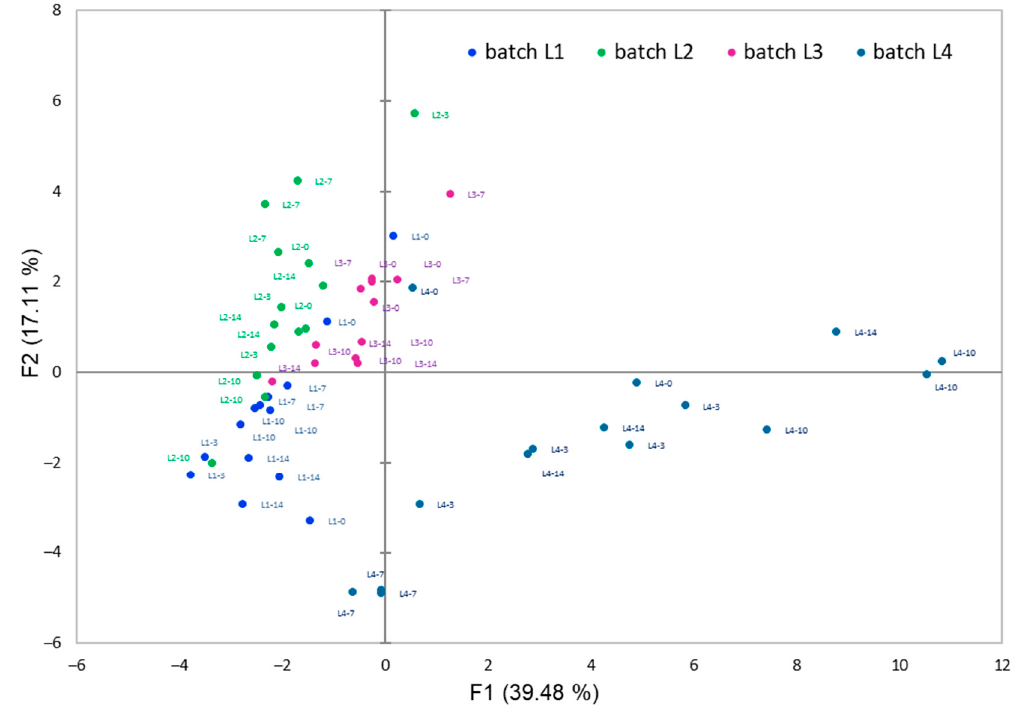
Figure 3. PCA of volatile compounds of the four analyzed batches at five different storage times (0, 3, 7, 10, and 14 days). L1, L2, L3, and L4 refer to batches, and the number after hyphen refers to storage time. A different color was assigned to different batches.